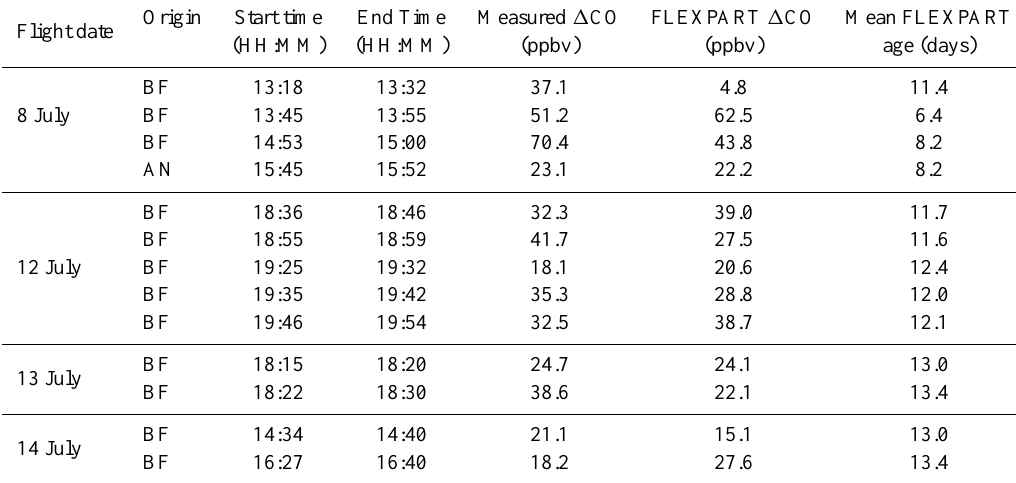
Table 2. Start and end time of the 13 selected time periods. In addition, mean concentrations of 1 CO and FLEXPART 1 CO are presented as well as the mean FLEXPART fire tracer